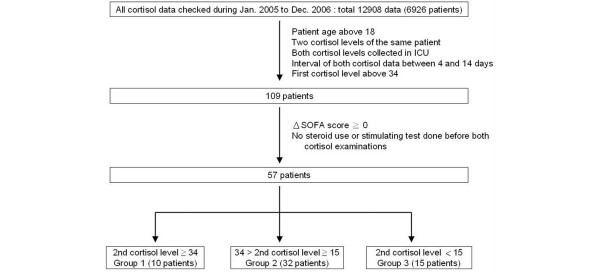
Flow chart of patient recruitment. ICU, intensive care unit; SOFA, Sequential Organ Failure Assessment.